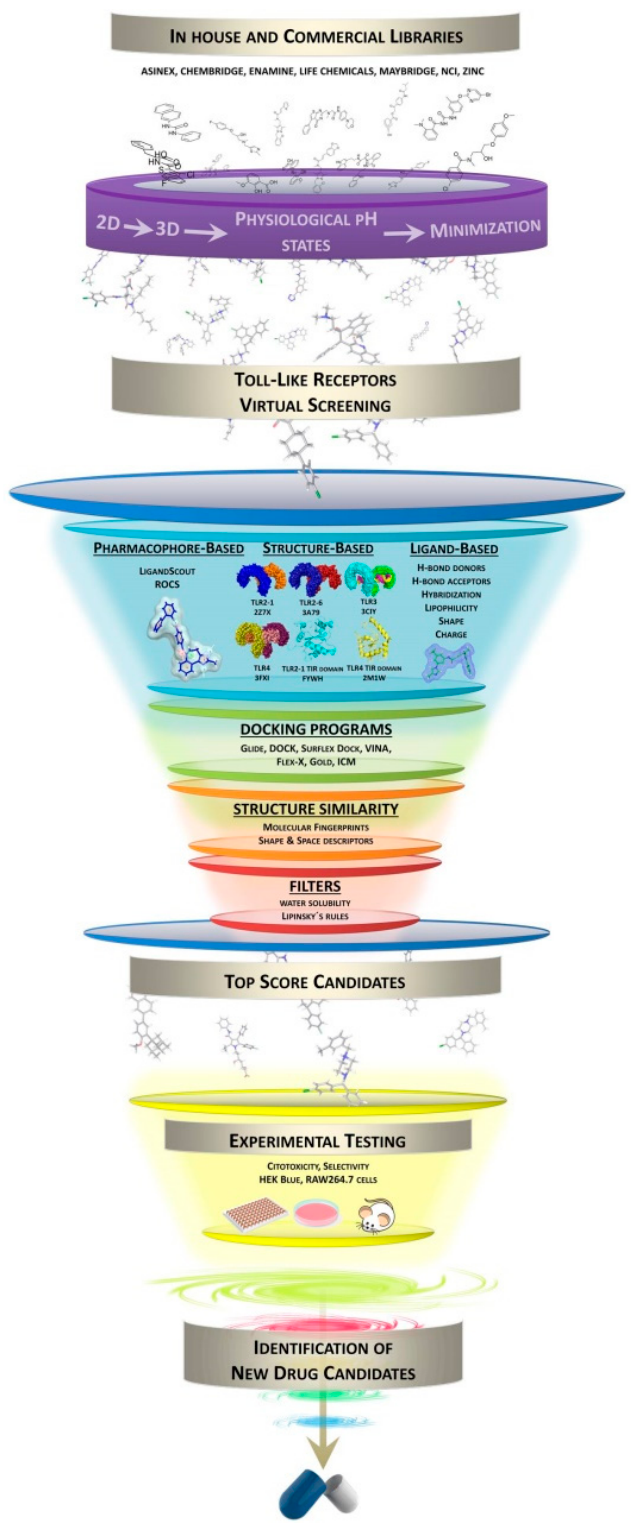
Figure 1. Summary of the virtual screening (VS) protocols applied for the search for novel Toll-like receptors (TLR) modulators: access to databases and preparation/filtering of small-molecules; pharmacophore generation; docking calculations; selection of candidates; experimental testing, and final identification of drug candidates.